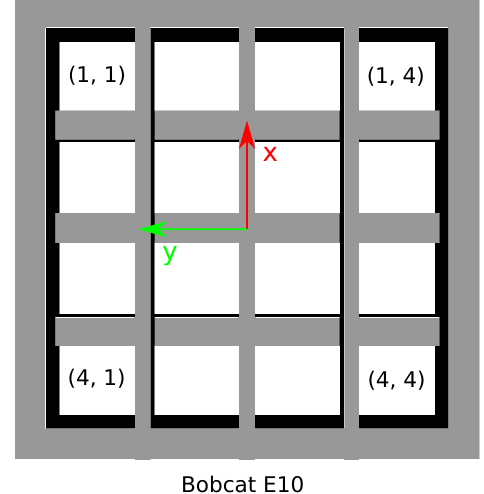
Figure 20. Reference for the scaled steel grizzly